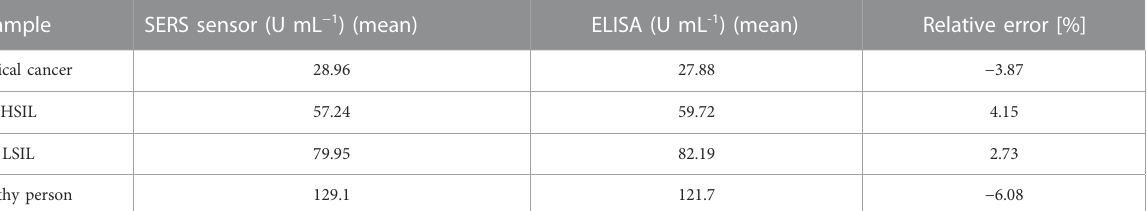
TABLE 2 Serum and ELISA immunoassay results from clinical serum samples.